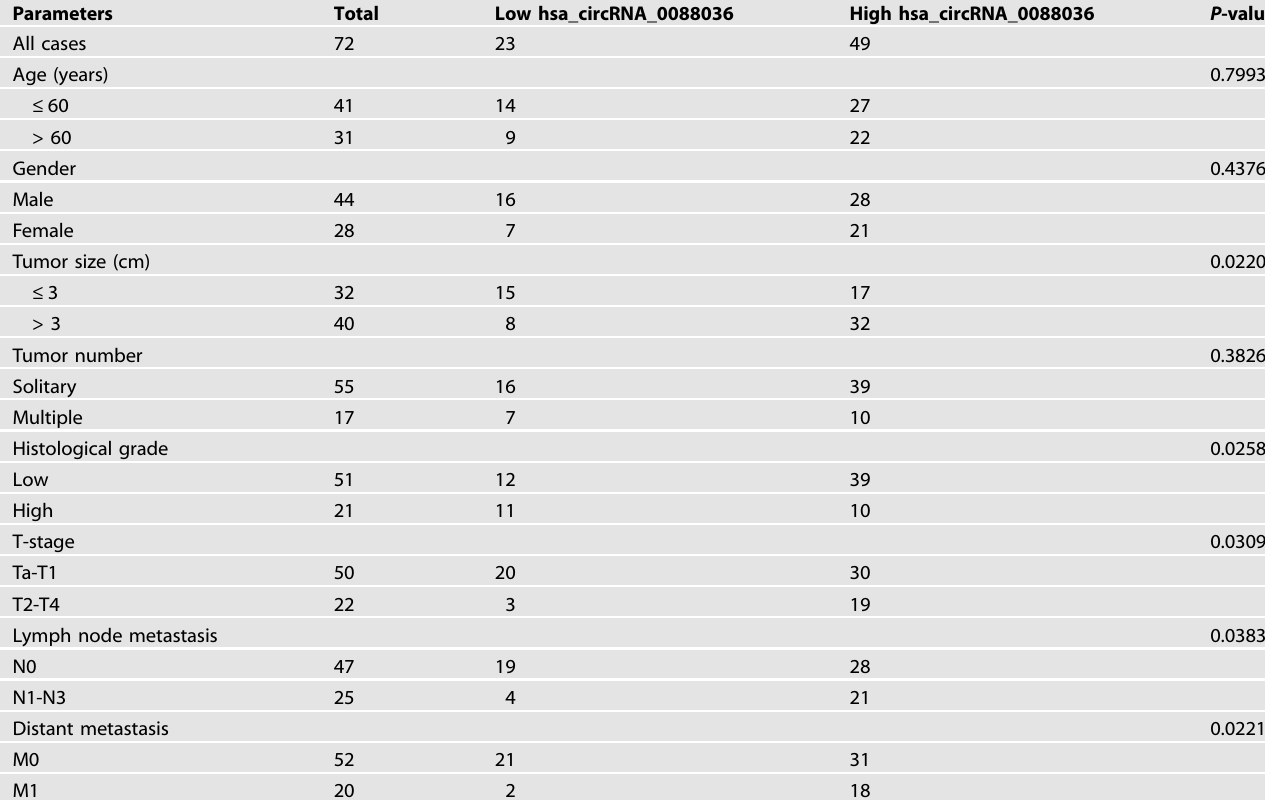
Table 1. The relationship between hsa_circRNA_0088036 expression and clinicopathologic characteristics of Bca.